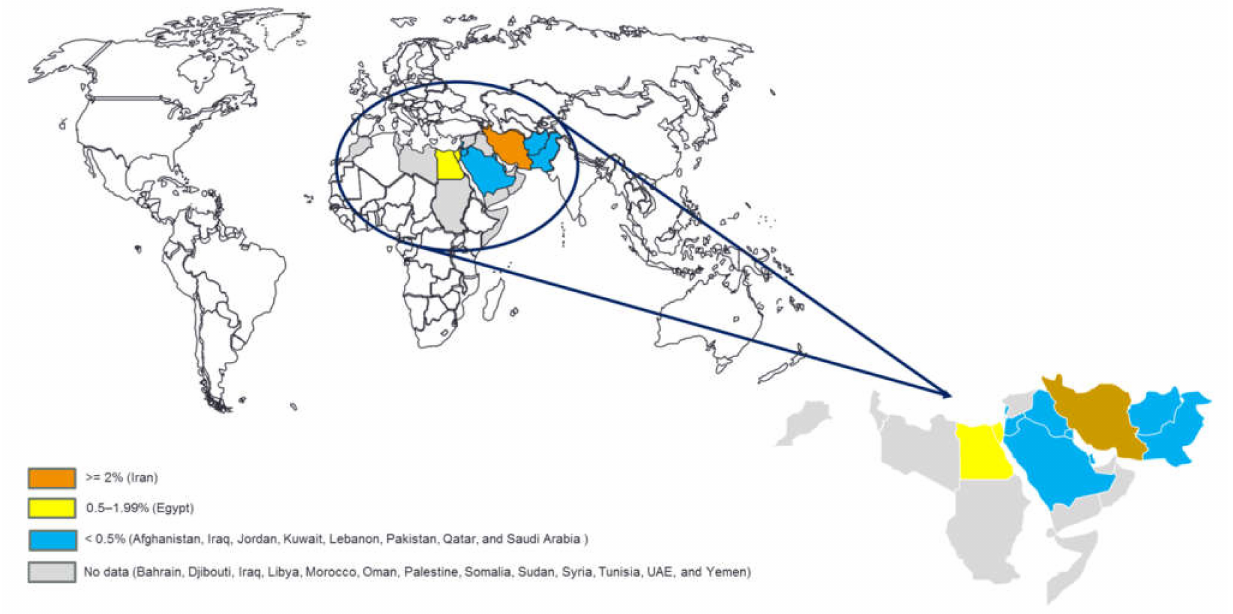
Figure 3. Map of the geographical distribution of HTLV-1 infection in countries of the Eastern Mediter- ranean Regional Office of the World Health Organization (drawn based on the epidemiological reports in the general population or blood donors included in this